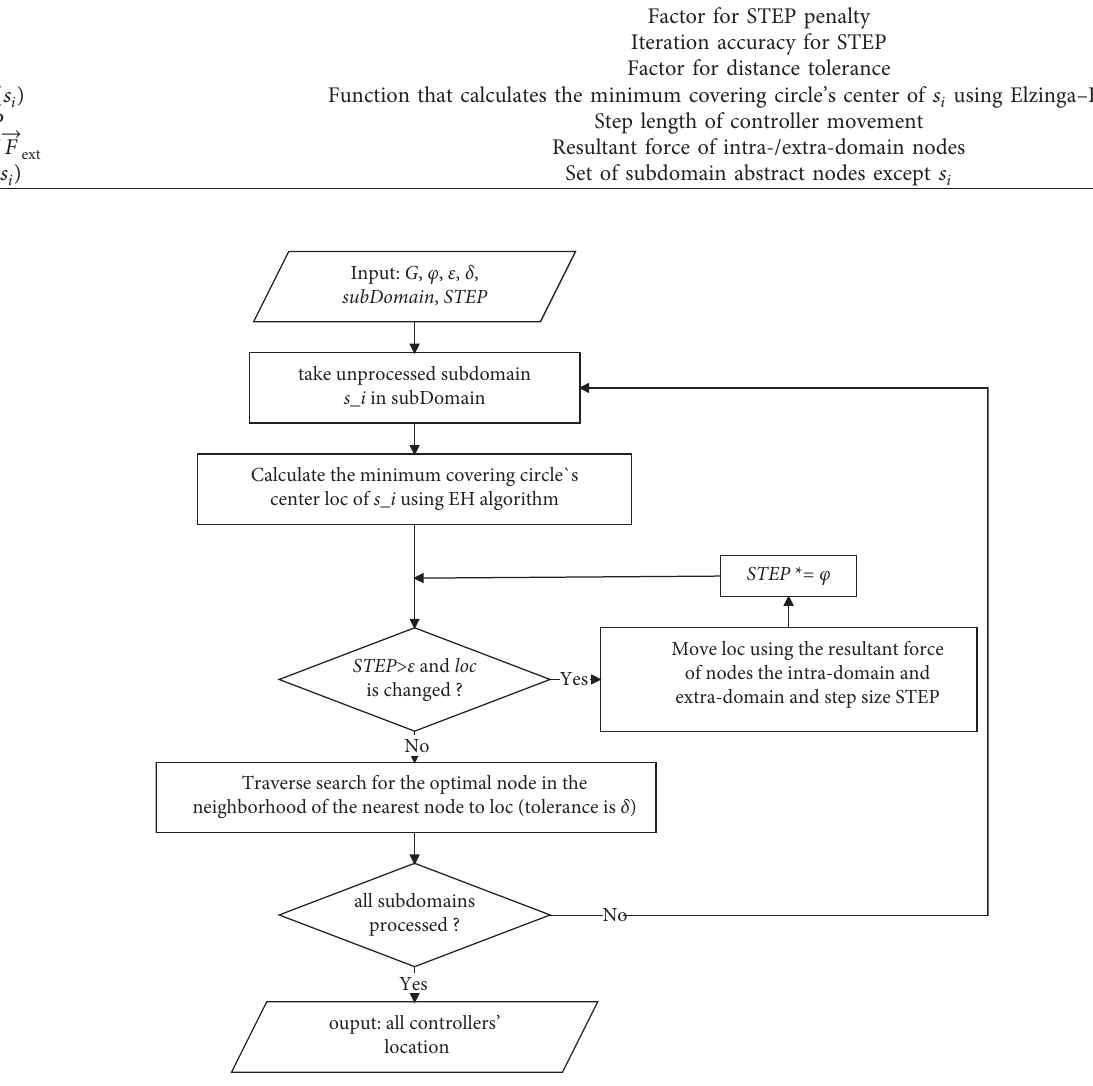
Figure 4: The flow diagram of Algorithm